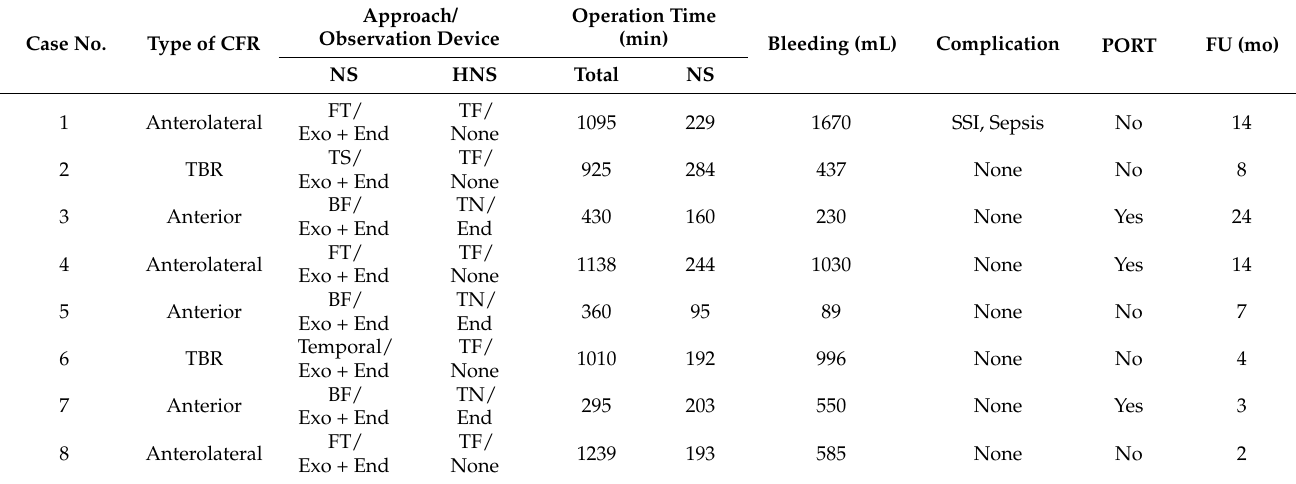
Table 1. Clinical data of eight patients who underwent CFR using exoscope and endoscope combination technique.